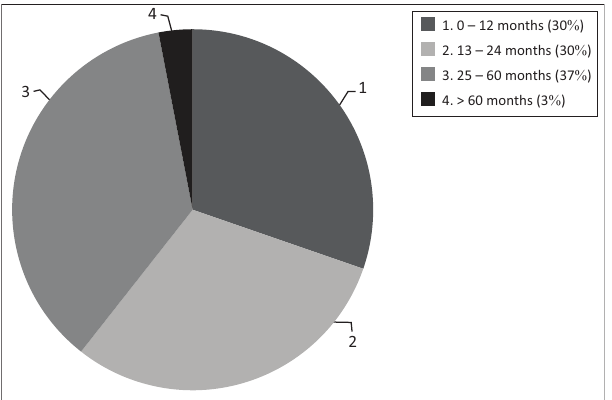
FIGURE 1: Cases with fractures according to age group ( N =